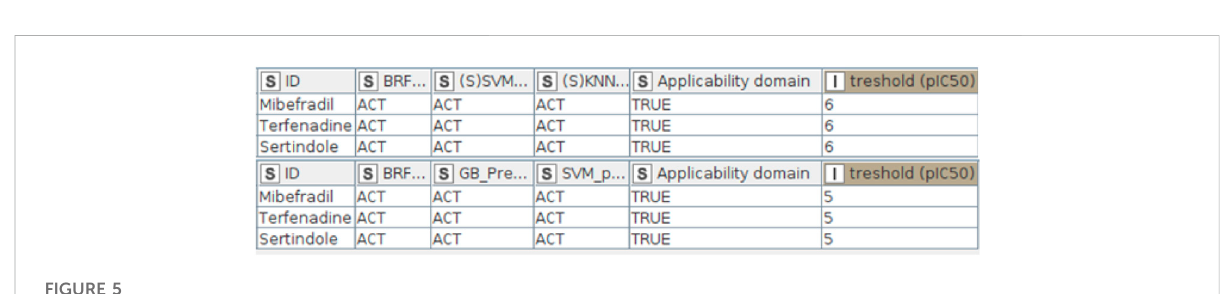
FIGURE 5 Output tables returned by the KNIME work fl ow for the three compounds examined: mibefradil, sertindole, and terfena fi de.